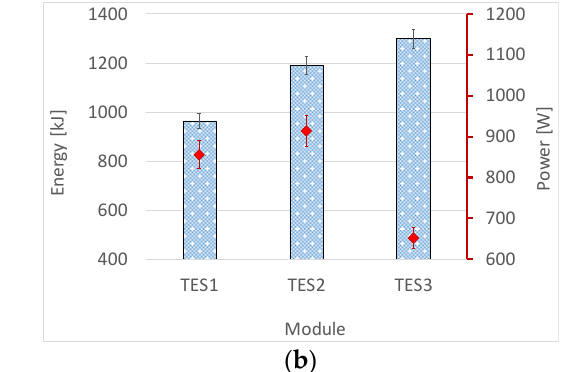
slightly more than TES (cid:2870) .